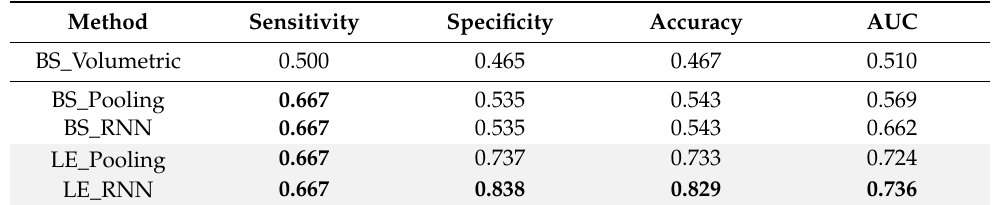
Table 5. Performance of different methods in prediction of disease progression. Bold font indicates best result in each performance metric achieved by the